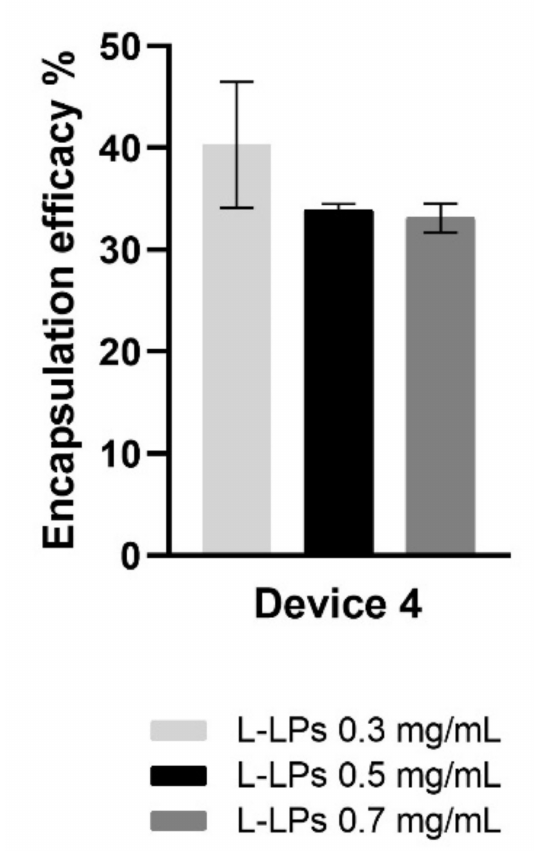
Figure 9. EE (%) of L-LPs encapsulating several lysozyme concentrations (0.3, 0.5, and 0.7 mg mL − 1 ) produced using device 4. Results represent mean ± SD, n = 3 independent batches.